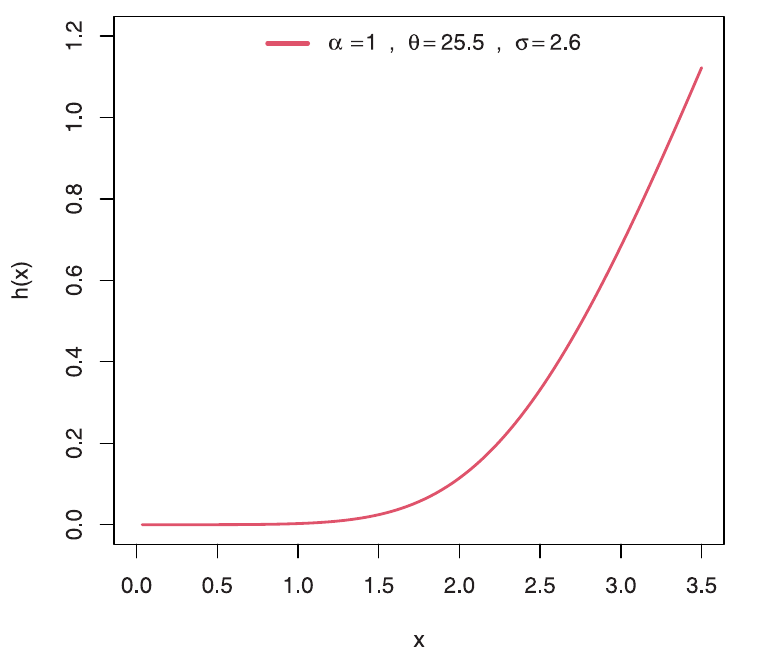
Fig 7. Plots of EGuNH hazard rate for a variety of parameter combinations.